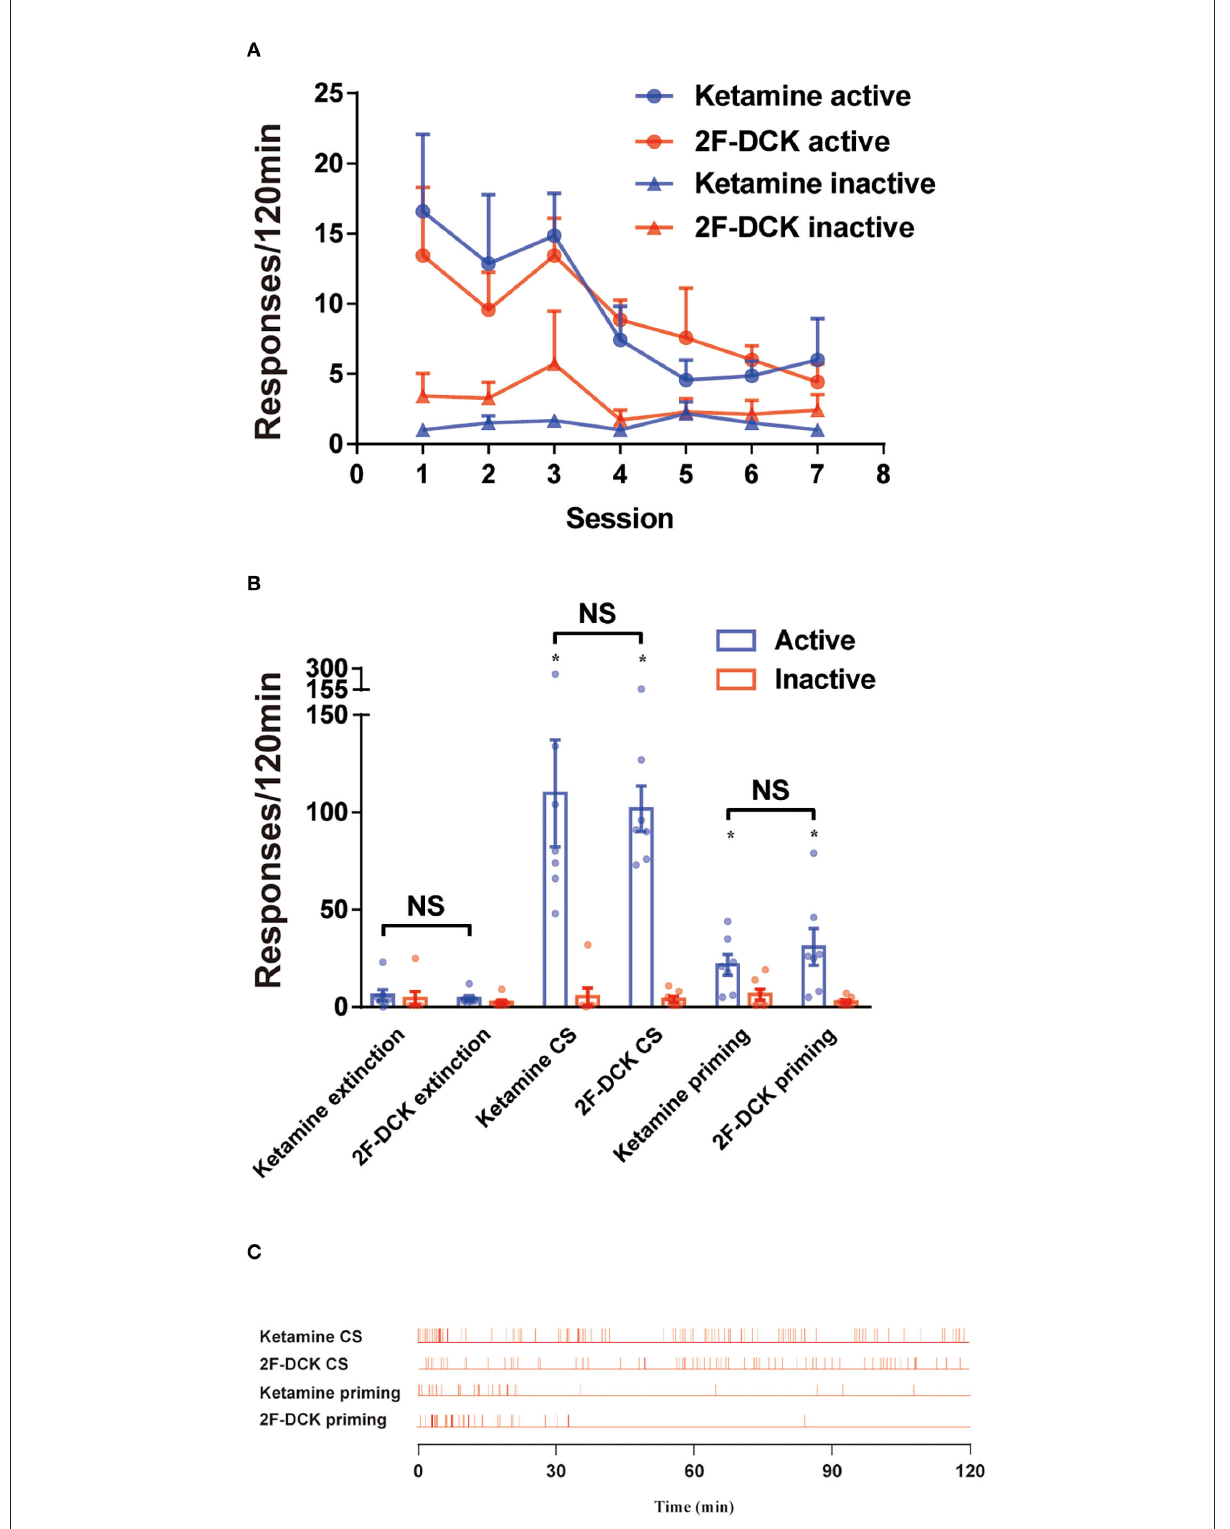
FIGURE3 The extinction and reinstatement of 2F-DCK and ketamine. (A) The active or inactive responses between the 2F-DCK and ketamine groups per 2h session for 7 days of extinction training were gradually decreased. (B) Mean ( ± SEM) number of responses during the final extinction session, cue-induced, and drug-priming reinstatement tests as a function of the group. There was a relative increase in responses from extinction to reinstatement in both the 2F-DCK and ketamine groups. Each bar represents mean ± SEM ( n = 8 per group). * P < 0.05 in comparison with extinction. (C) The representative raster plot for active responses as a function of time during a 2-h reinstatement testing session. Ketamine- or 2F-DCK-associated CS-induced responses were completed across the session, but both ketamine and 2F-DCK priming responses were mostly completed within the first